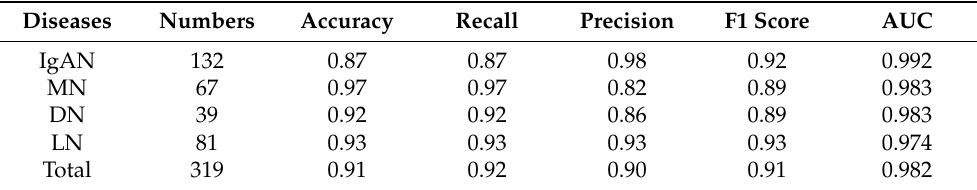
Table 4. MTL-IF method performance in disease diagnosis based on blurred IF